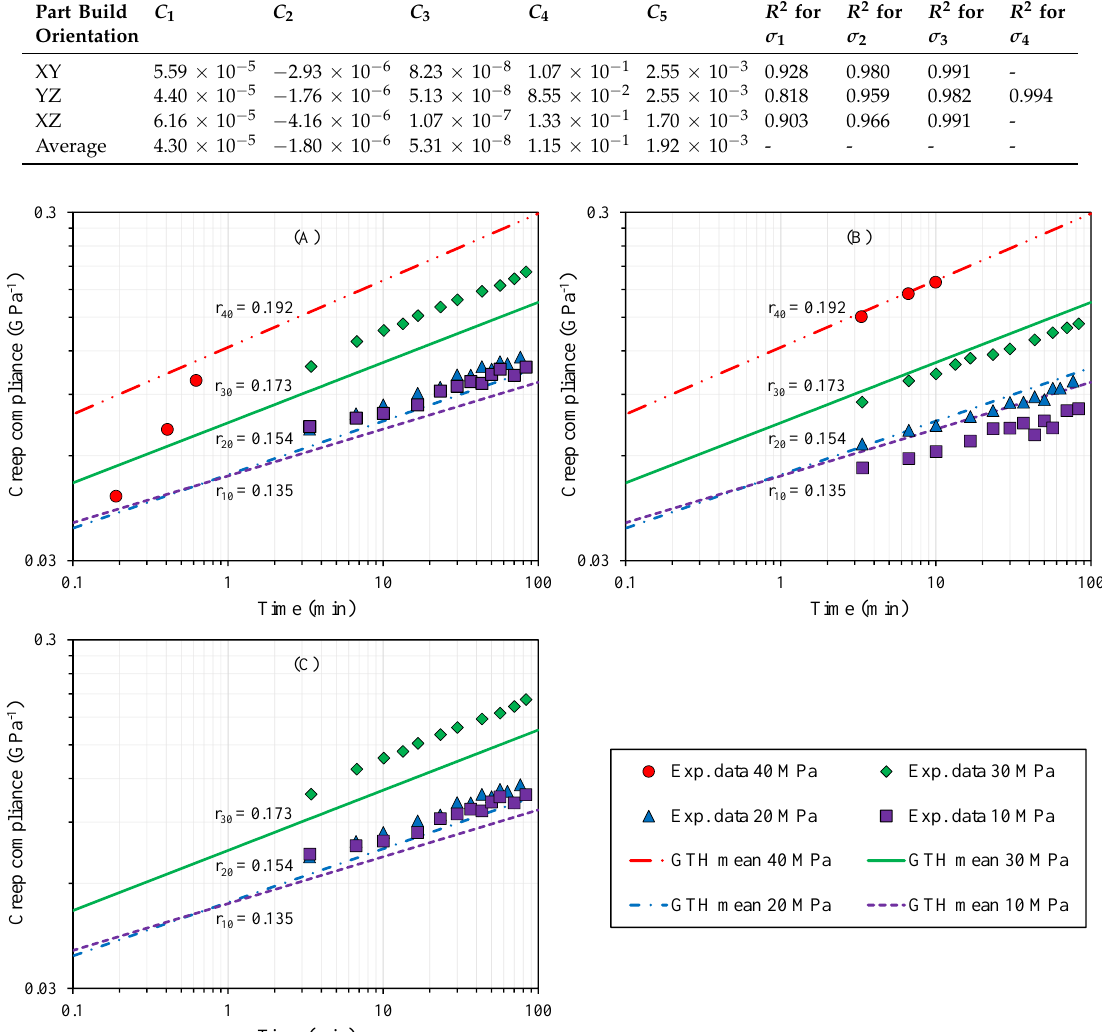
Figure 4. Creep compliance performance for different part build orientations at room temperature (RT): ( A ) XY, ( B ) YZ, and ( C ) XZ. XY and XZ were unable to reach 40 MPa. Averaged GTH coefficients (solid and dashed lines) showed the ability to model the creep compliance’s dependence on